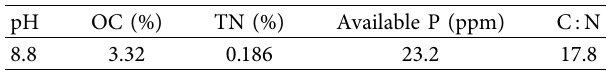
Figure 1: Location map of the study area. Table 1: Chemical properties of farm yard manure